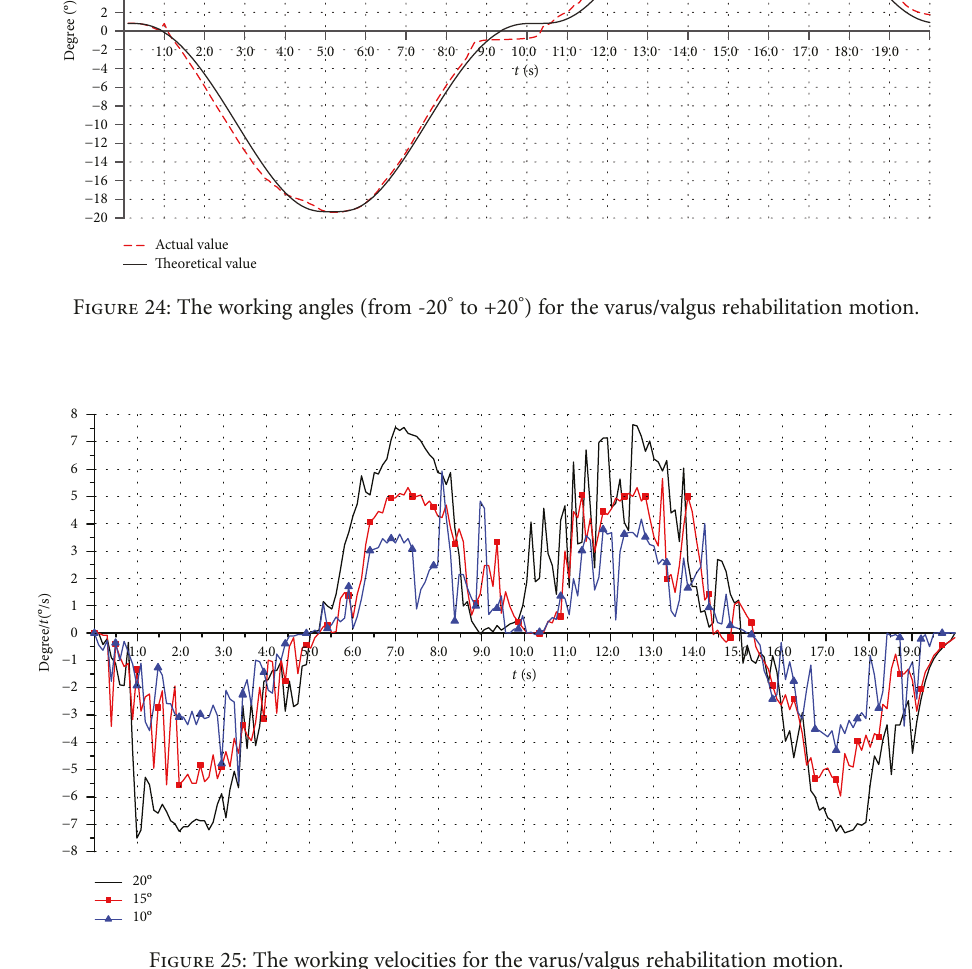
Figure 25: The working velocities for the varus/valgus rehabilitation motion.